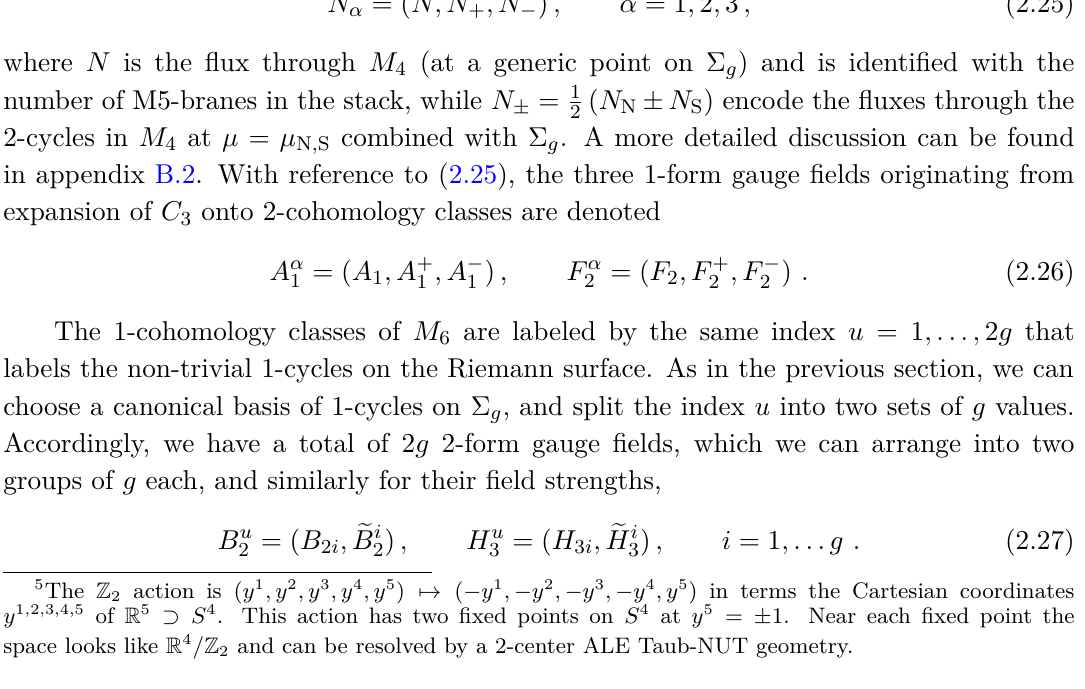
Figure 1 . Schematic depiction of the space M 4 comprised by the 2-sphere S 2 the µ interval. The space M is the blow-up resolution of S 4 / Z 4 with S 2 at µ = µ and µ = µ N S ϕ